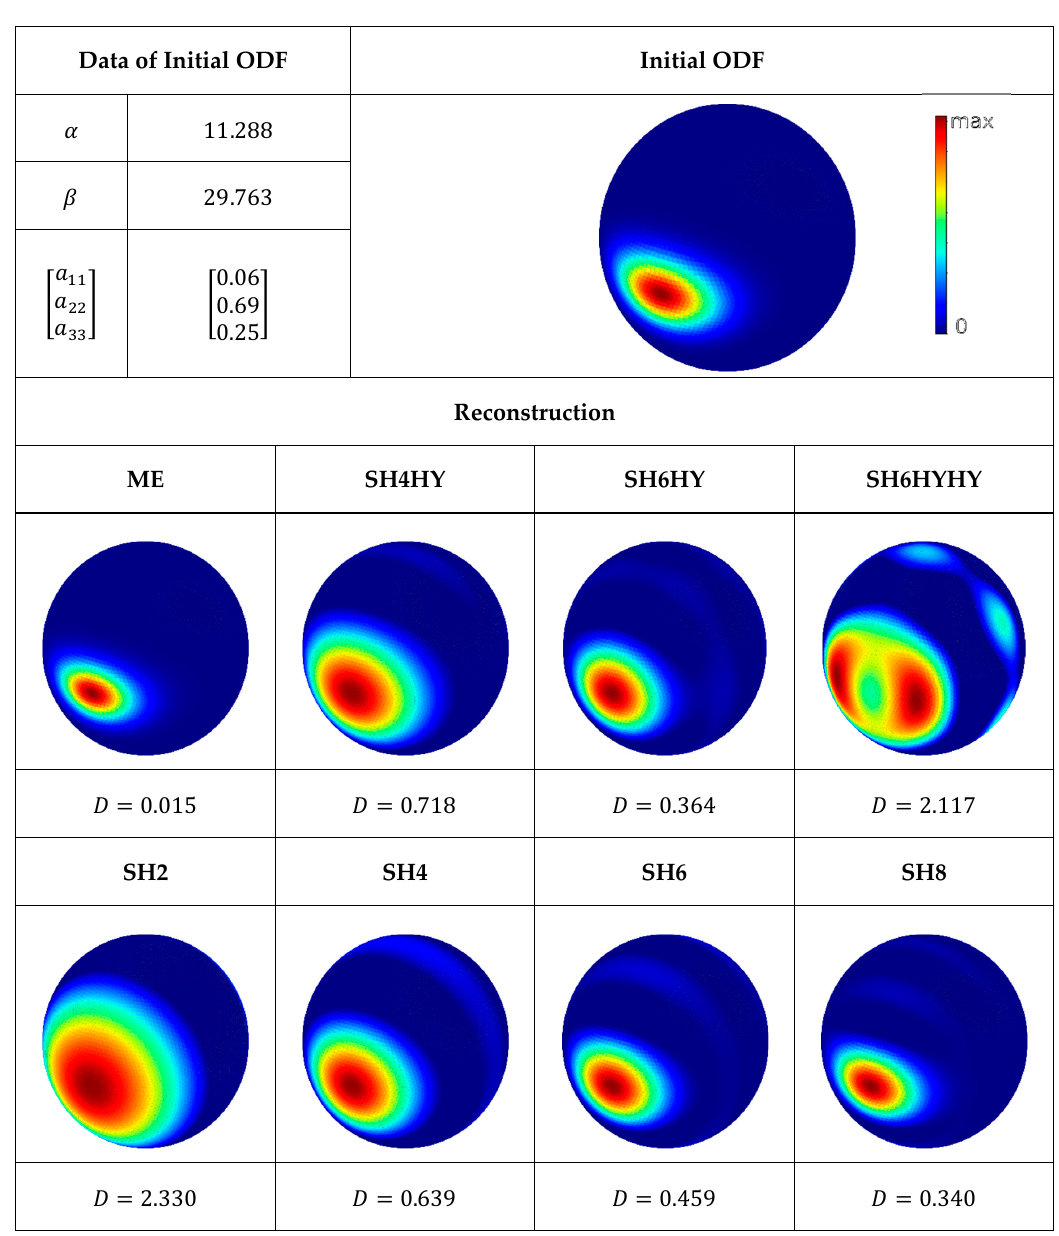
Figure 5. Top: Initial ODF and data of second test case. Bottom: Reconstruction of test case with the different reconstruction methods.